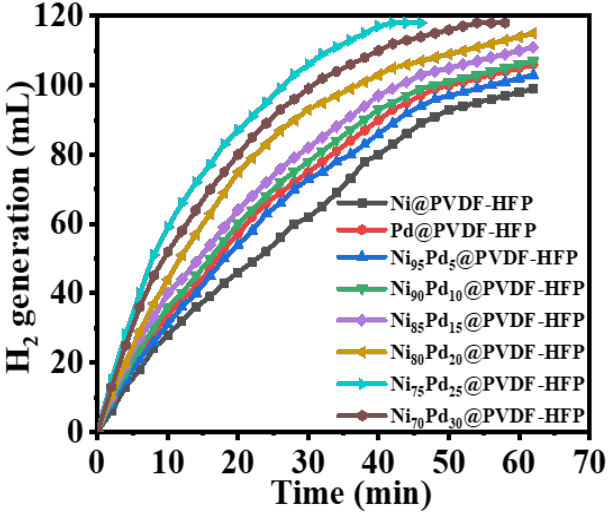
Figure 6. The impact of Ni 1 − x Pd x @PVDF-HFP membranes on H 2 generation by SBH hydrolysis. The catalyst amount = 100 mg, [SBH] = 1 mmol, and T = 298 K. Table 1. H 2 evolved yields and rates by polymer membranes used different Ni/Pd ratios at 298 K.